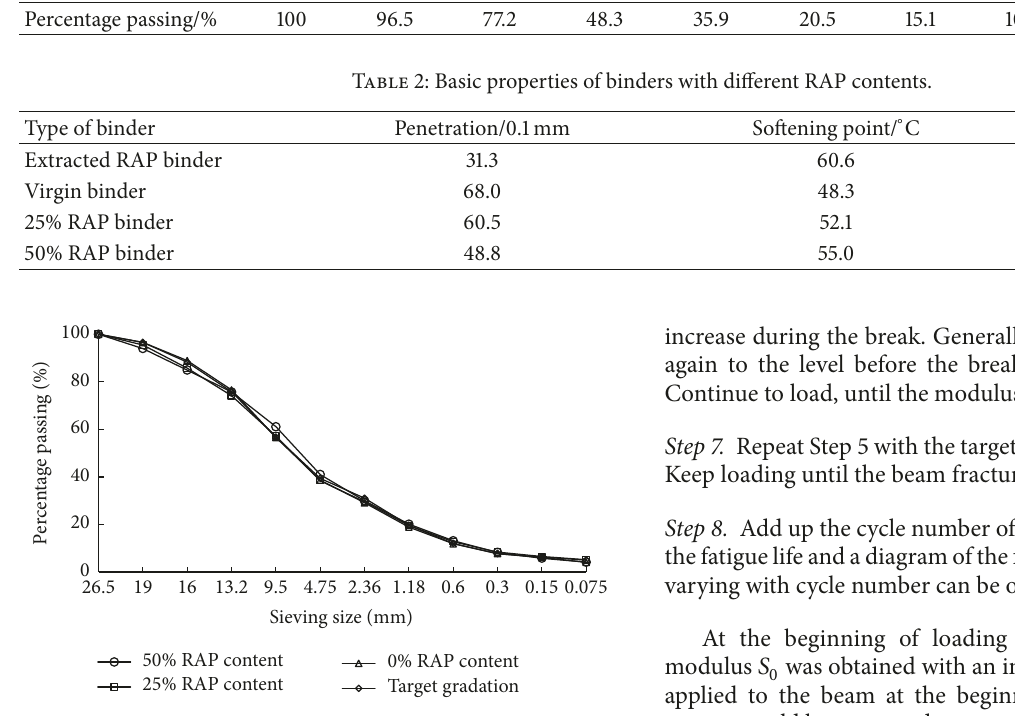
Figure 1: Gradations of asphalt mixtures with different RAP con-